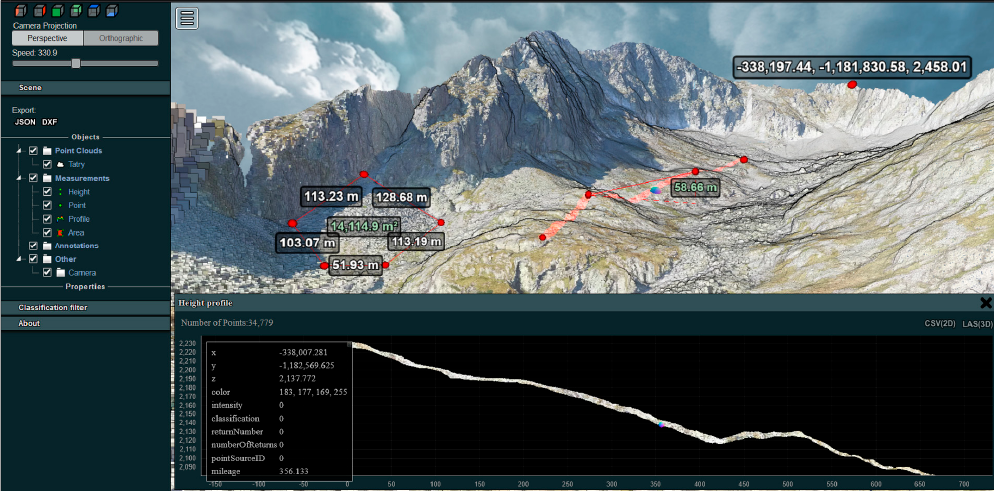
Figure 14. Visualization of 3D point cloud via Potree online tool.